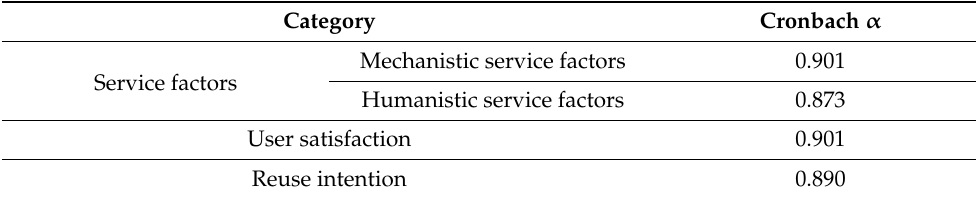
Table 1. Results for reliability concerning measurement instruments.